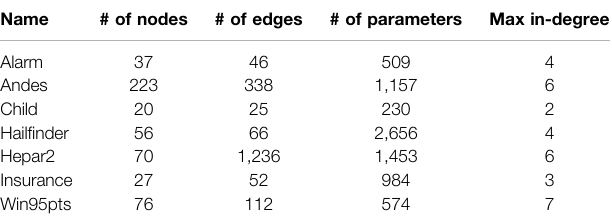
TABLE 1 | Bayesian networks used in the simulation